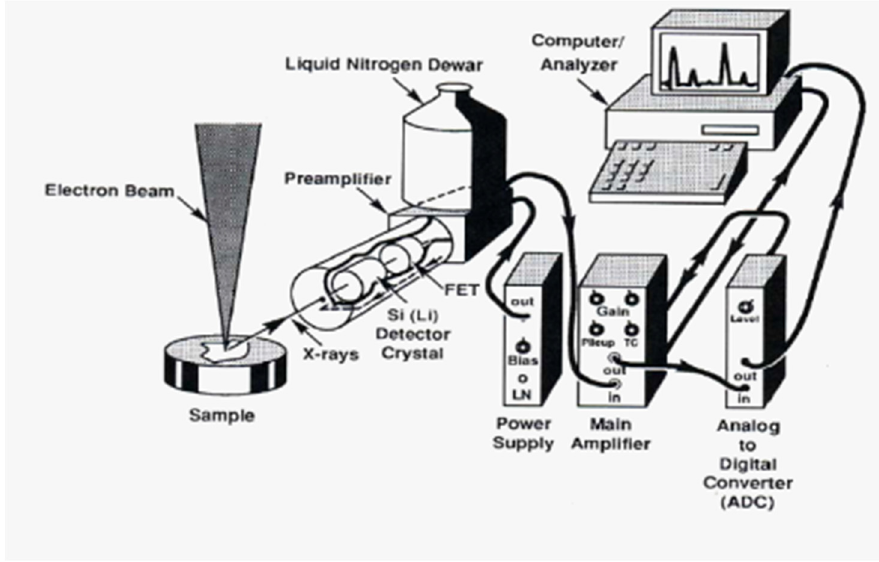
Figure 4. Schematic diagram of an EDX system.